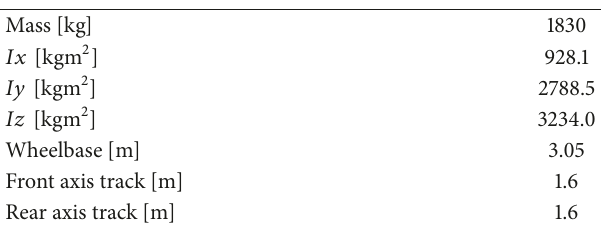
Table 6: Vehicle principal